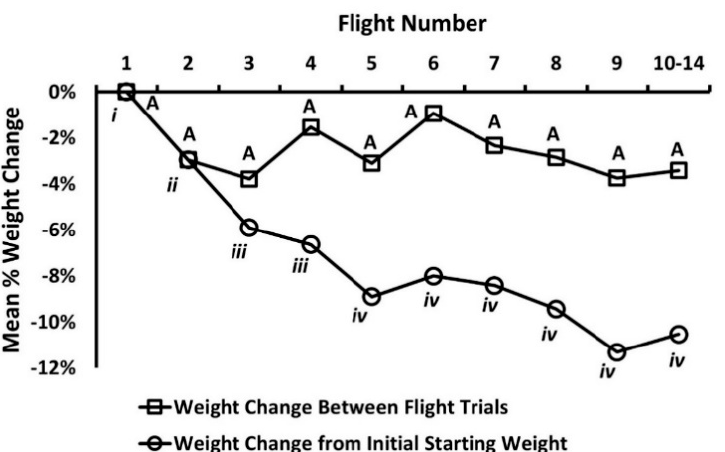
Figure 3. Mean percentage change in weight for adult Rhynchophorus palmarum across successive flight trials and in relation to initial starting weight at preceding flight or as function of weight at the commencement of flight trial one. Data points with different letters indicate significant differences at the 0.05 level for weight change from weight at preceding flight trial (upper case letters) or initial starting weight at commencement of flight 1 (Roman numerals).